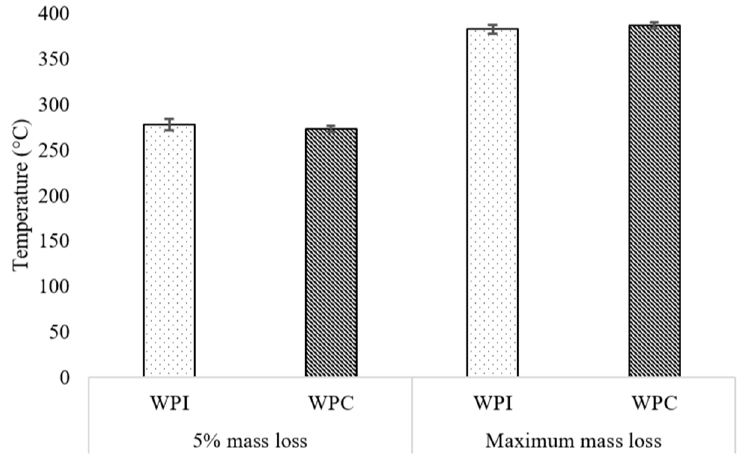
Figure 6. Five percent mass loss temperatures (T 5% ) and maximum mass loss temperatures (DTG max ) of WPI and WPC-based polymer samples.